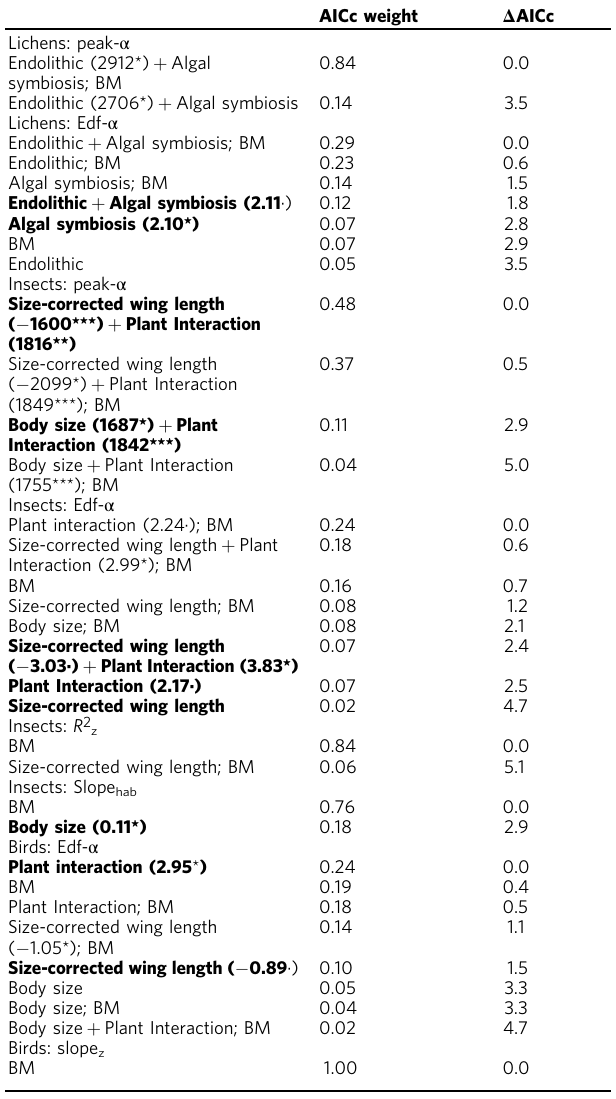
Table 1 List of generalised least square regression models testing for the in fl uence of organismal features on those diversity responses with strong evidence of phylogenetic